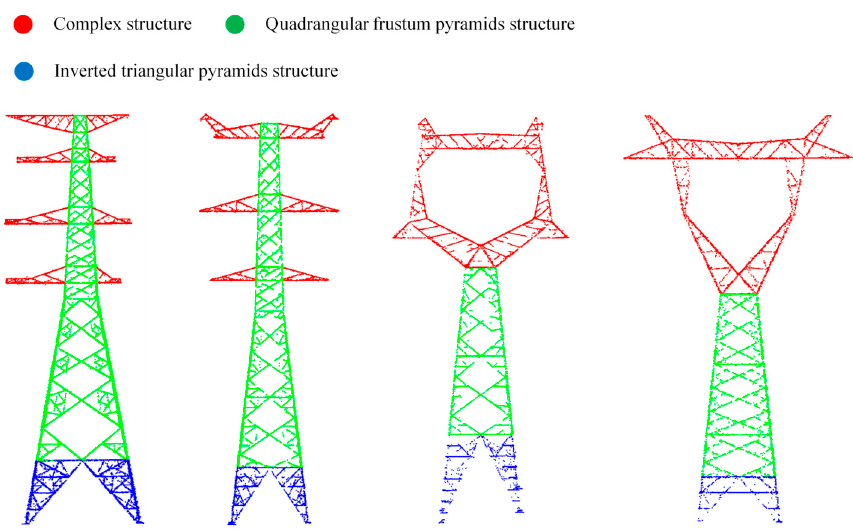
Figure 2. The structure of power pylon.